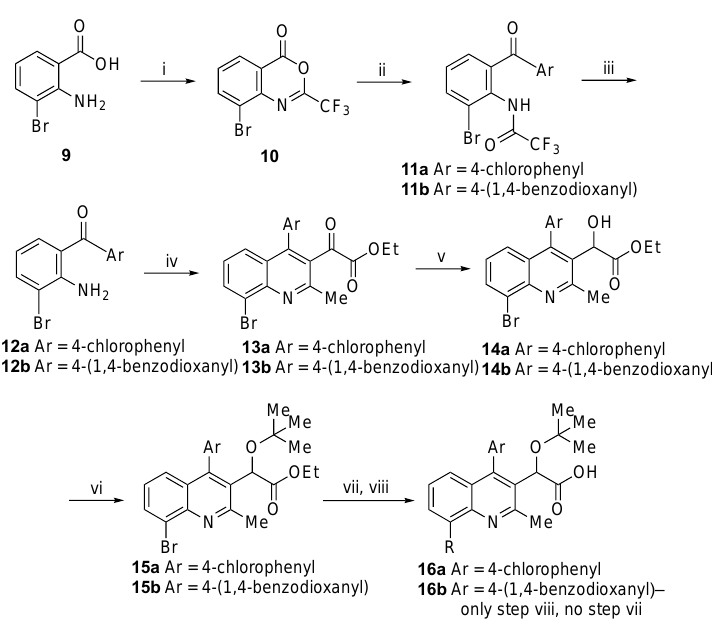
Table 4. In vitro IN multimerization EC50 activities of 8-substituted-4-(1,2-benzendioxanyl) quino- lines. a Data from Jentsch N. et al.